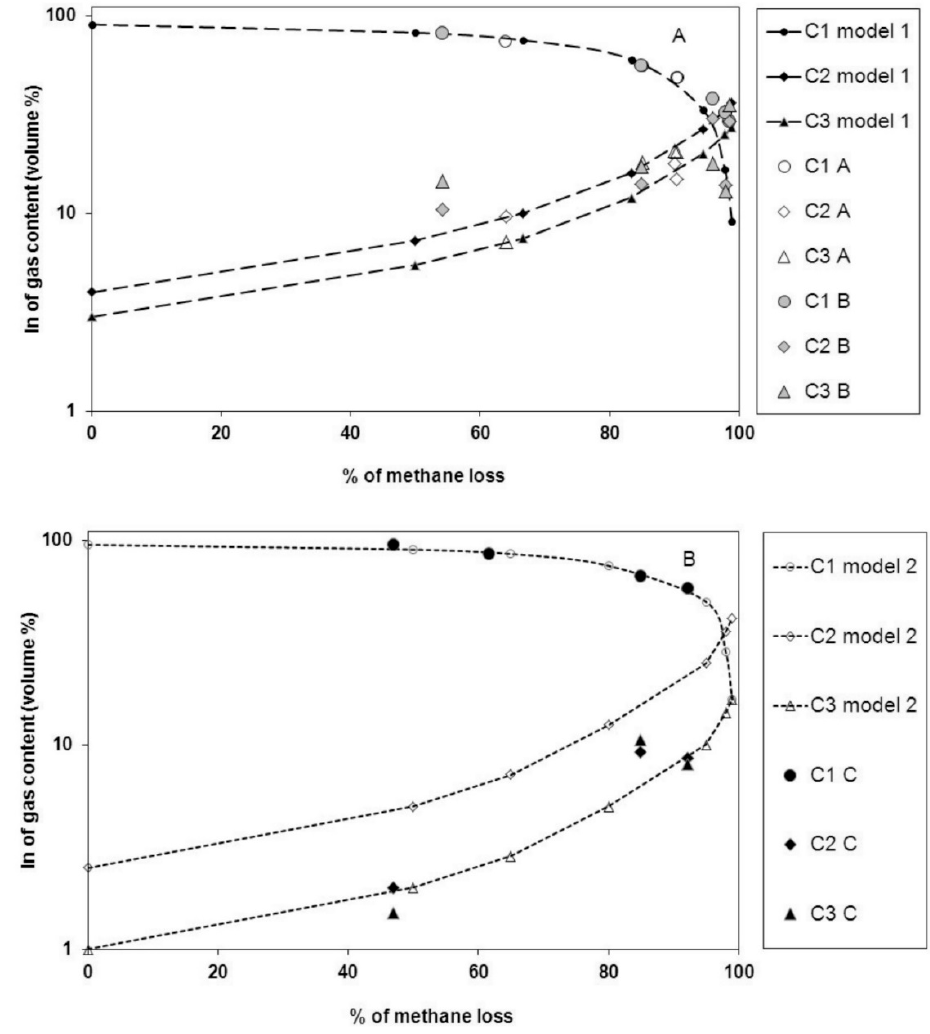
Figure 3. Calculated changes in the chemical composition of the residual gas with increasing methane loss for the model gas mixture No. 1 and experimental data of Mikulov and Ostrava formations ( A ), and for model gas mixture No. 2 and data of the Liten formation ( B ).